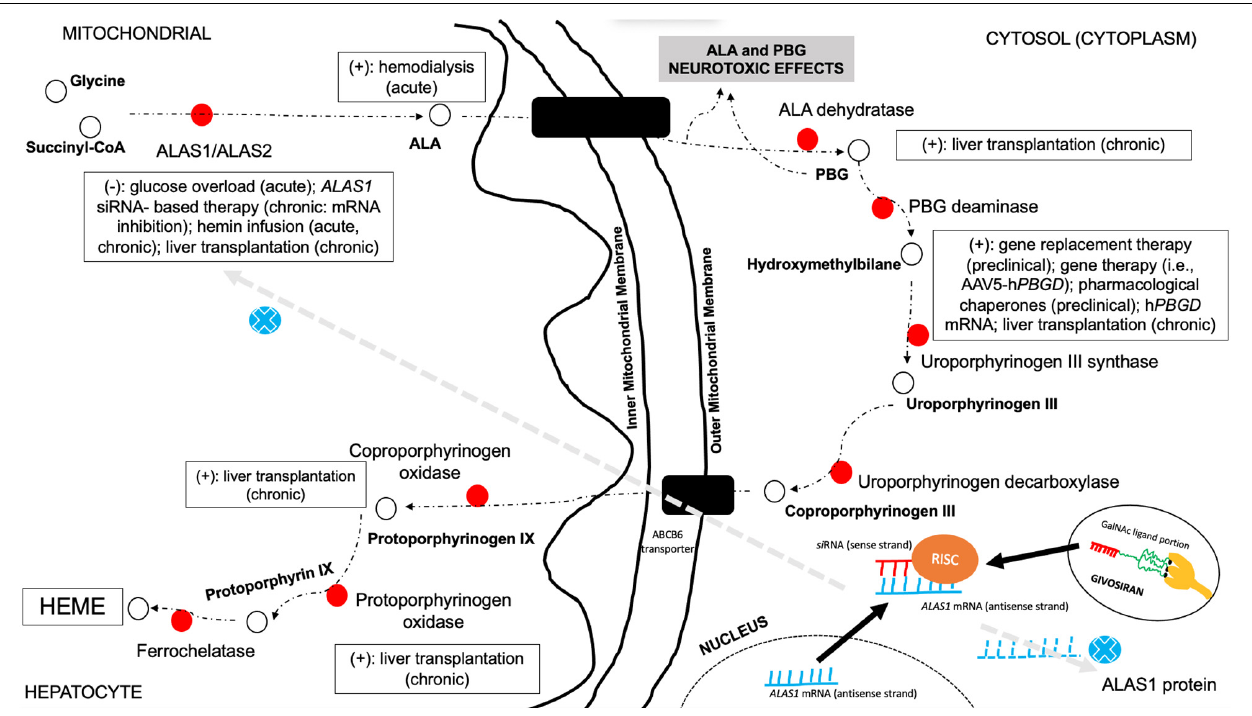
FIGURE 5 | Possible therapeutic approaches in the management of AHP and their associated mechanism of action in the multistep pathway of heme biosynthesis. This figure highlights the different steps of heme biosynthesis pathway in which different therapy options may be used to treat AHP. Glucose overload and hemin-based therapies are directed to downregulate hepatic ALAS1 production and reducing, thus, heme biosynthesis pathway activation, limiting neurotoxic metabolite production. Hemodialysis represents an option to withdraw neurotoxic metabolites from circulation in acute severe presentation without available hemin-based therapy. Pharmacological chaperone aids in the proper function of misfolded enzymes and directing properly to the targeted route. Gene therapy approaches are directed to provide liver production of the specific deficient enzyme of the pathway. Small interfering RNA-based therapies are targeted to hepatocyte delivery, promoting association with the antisense strand of ALAS1 mRNA and the formation of RISC in the cytosol and then inhibiting ALAS1 production. Liver or hepatocyte transplantation enables the restoration of normal functioning enzyme in different types of AHP. Legends: AAV5, adeno-associated virus type 5; ALA, delta-aminolevulinic acid; ALAS, delta-aminolevulinic acid synthase; CoA, coenzyme A; GalNAc, N -acetylgalactosamine; PBG, porphobilinogen; PBGD, porphobilinogen deaminase; RISC, RNA-induced silencing complex; siRNA, small interfering RNA; (+), treatment option for the step—normal enzyme activity; (–), treatment option associated with inhibition of enzyme